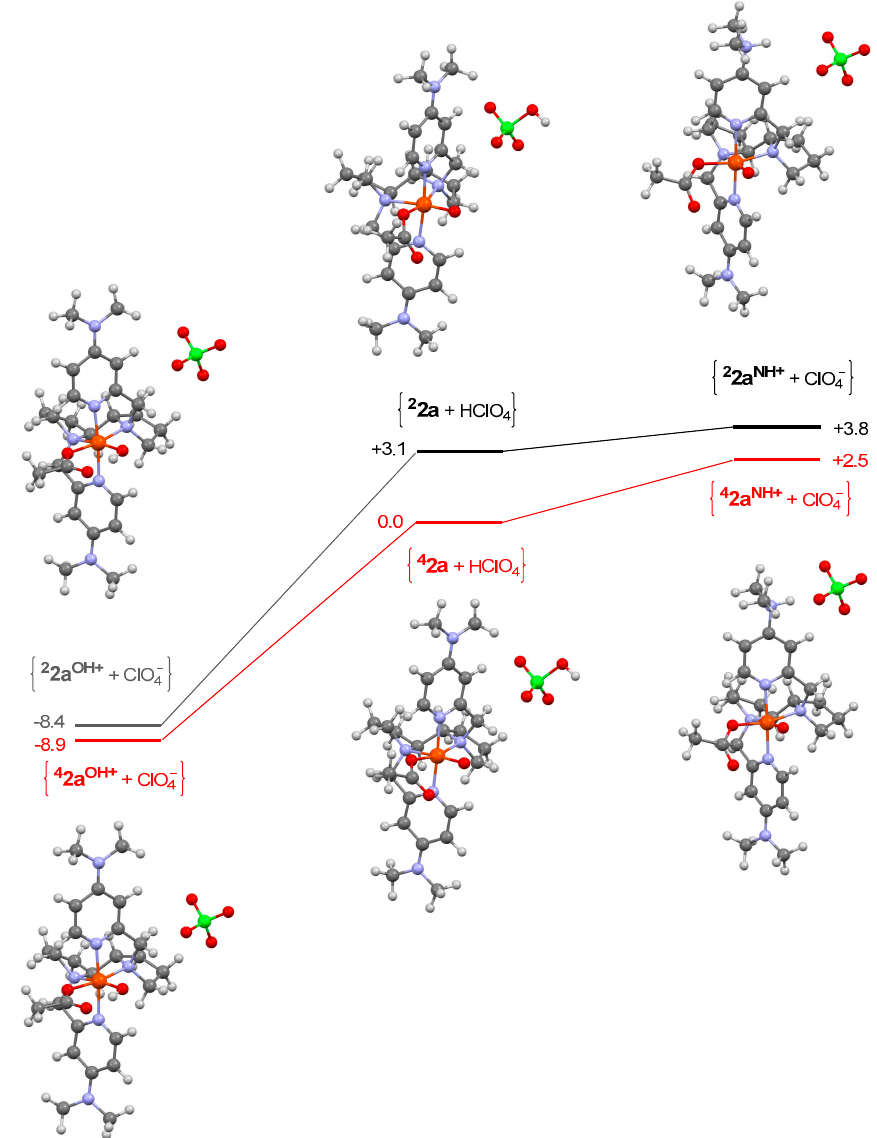
Figure 6. Optimized geometries and relative free energies (kcal/mol) of the non-protonated interme- diates of the type { 2a + HClO 4 }, as well as protonated at ligand ({ 2a NH+ + ClO 4 − }) and at terminal oxygen ({ 2a OH+ + ClO 4 − } on the S = 3/2 (red) and the S = 1/2 (black) energy surfaces. C, grey; H, light grey; N, violet; O, red; Cl, green; Fe, orange. Previously, it was reported that the protonation of the [(N 4 Py)Fe IV (O)] 2+ complex, with HClO 4 at the terminal Fe=O, eliminates the primary KIE for C-H bond breaking (mesitylene/d 12 -mesitylene: k H / k D drops from 31 to 1.0), which was interpreted as a changeover of the mechanism from direct hydrogen atom transfer (HAT) to proton- coupled electron transfer (PCET) [40]. We have compared competitive oxidations of cyclohexane/d 12 -cyclohexane in the absence and in the presence of HClO 4 and